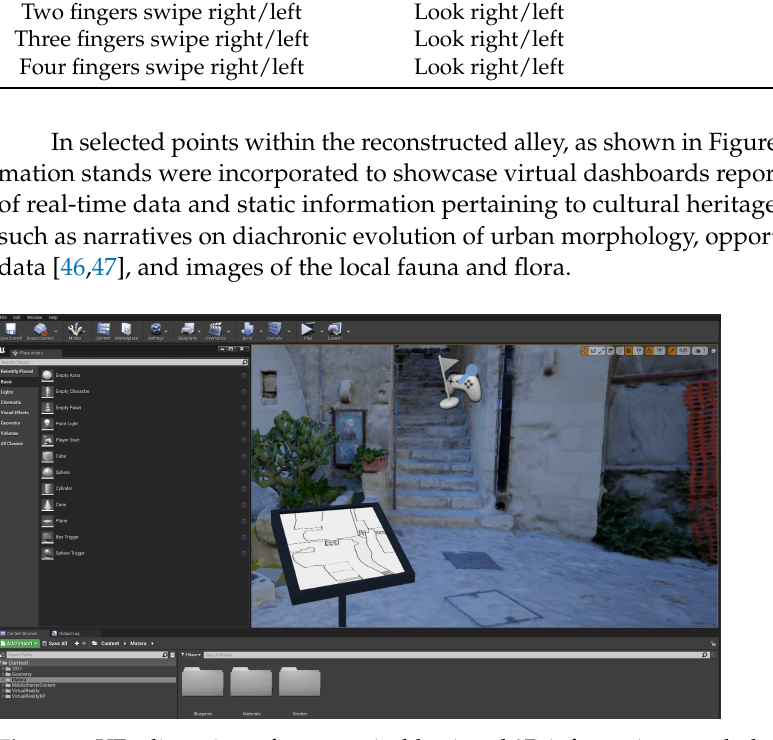
Figure 9. UE editor view of a customizable virtual 3D information stand placed within the recon- structed